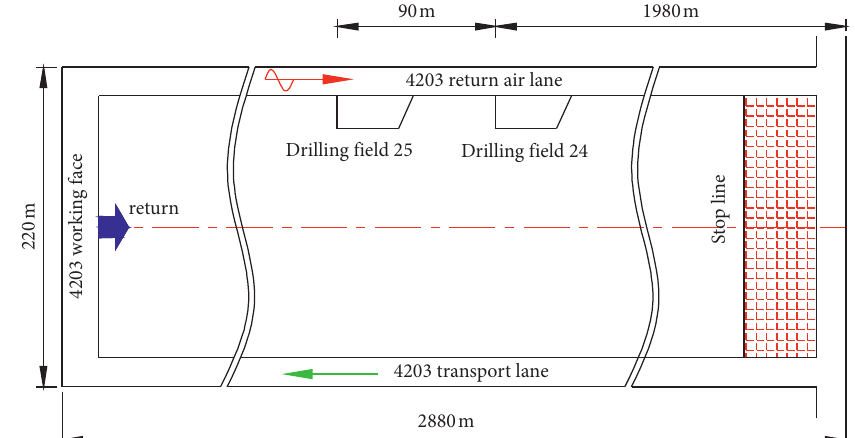
Figure 3: Location of the 24 and 25 gas drainage drilling field.